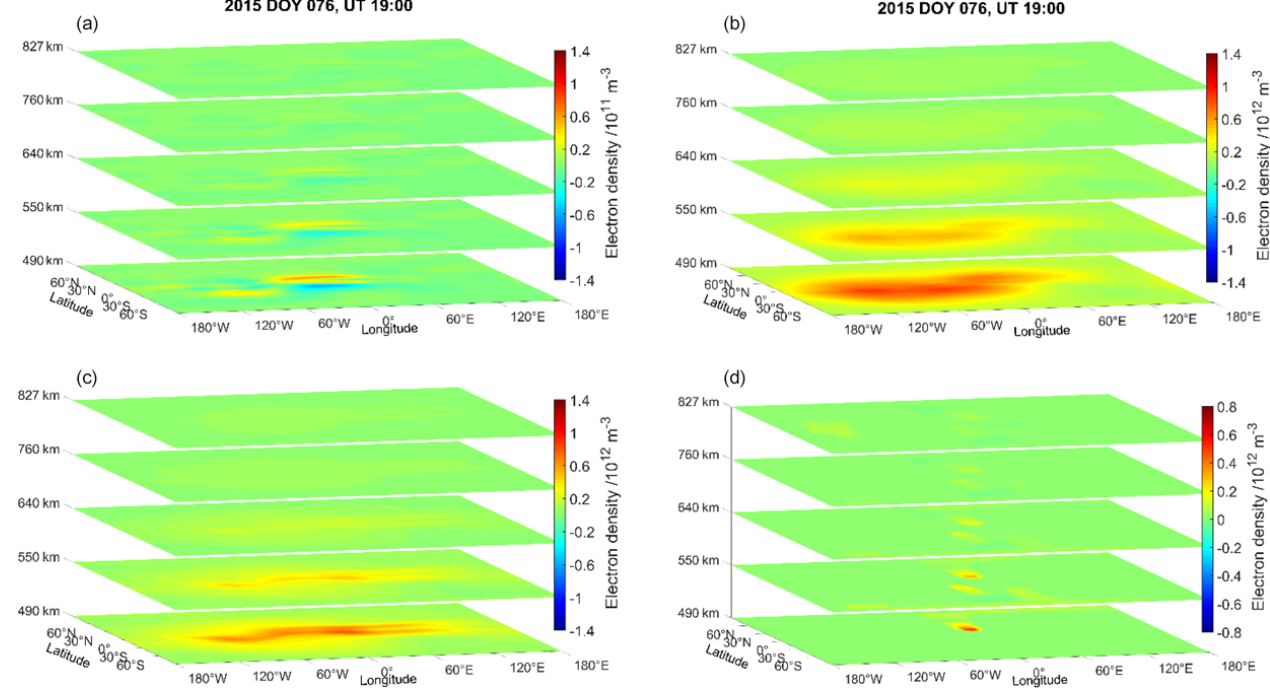
Figure 4. Reconstructed minus NeQuick-modelled electron density represented by layers at different heights between 490 and 827km. (a) Rotation with exponential decay. (b) Rotation. (c) Exponential decay. (d) SMART +